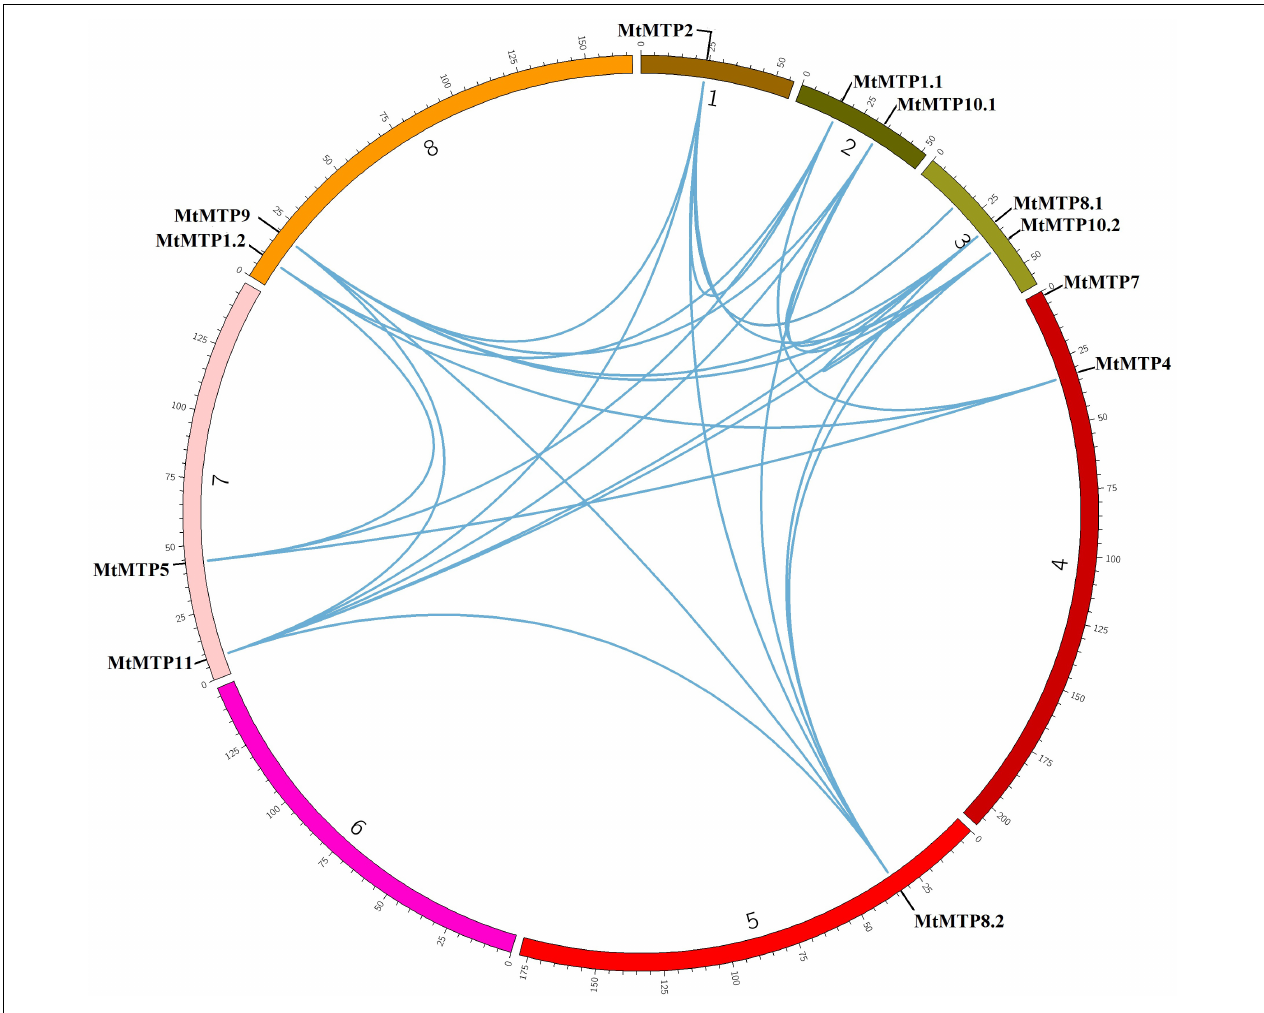
FIGURE 2 | Genome-wide synteny analysis of MTP gene family among eight M. truncatula chromosomes. The blue lines represented the syntenic orthologs and paralogs and displayed segmental duplication.